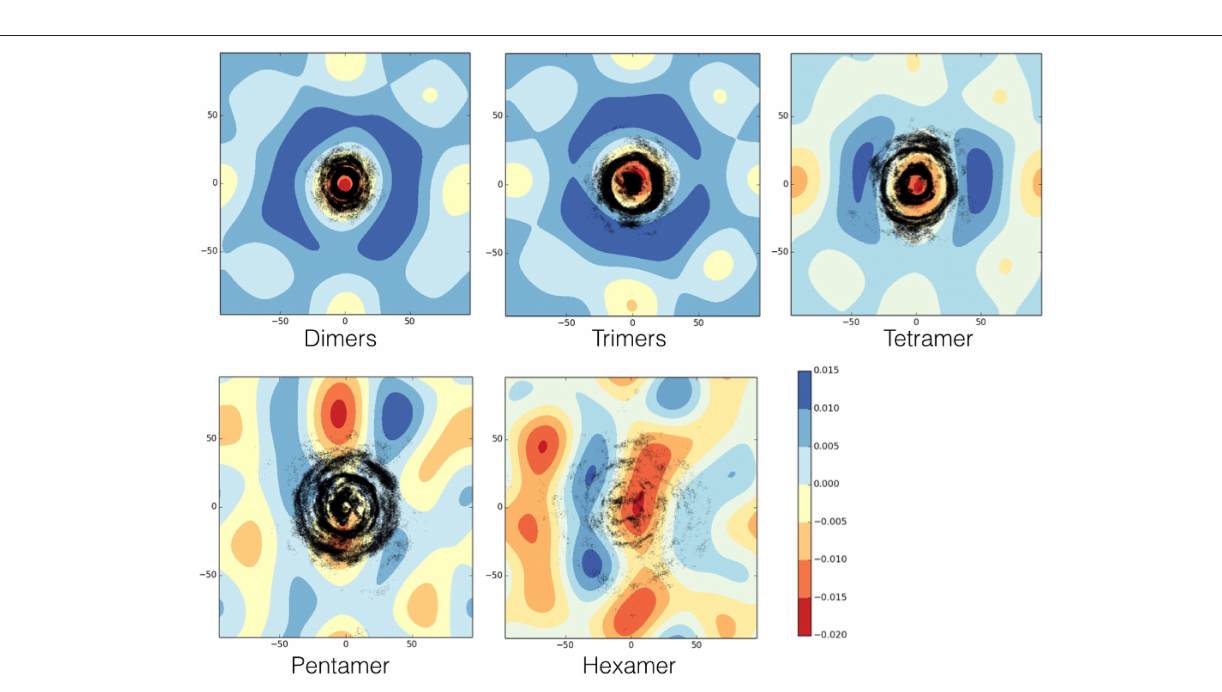
FIGURE 11 | Heat map of the membrane curvature as induced by each oligomeric state. Black dots correspond to the position of the center of mass of each monomer belonging to the oligomer. The units for membrane curvature are [nm − 1